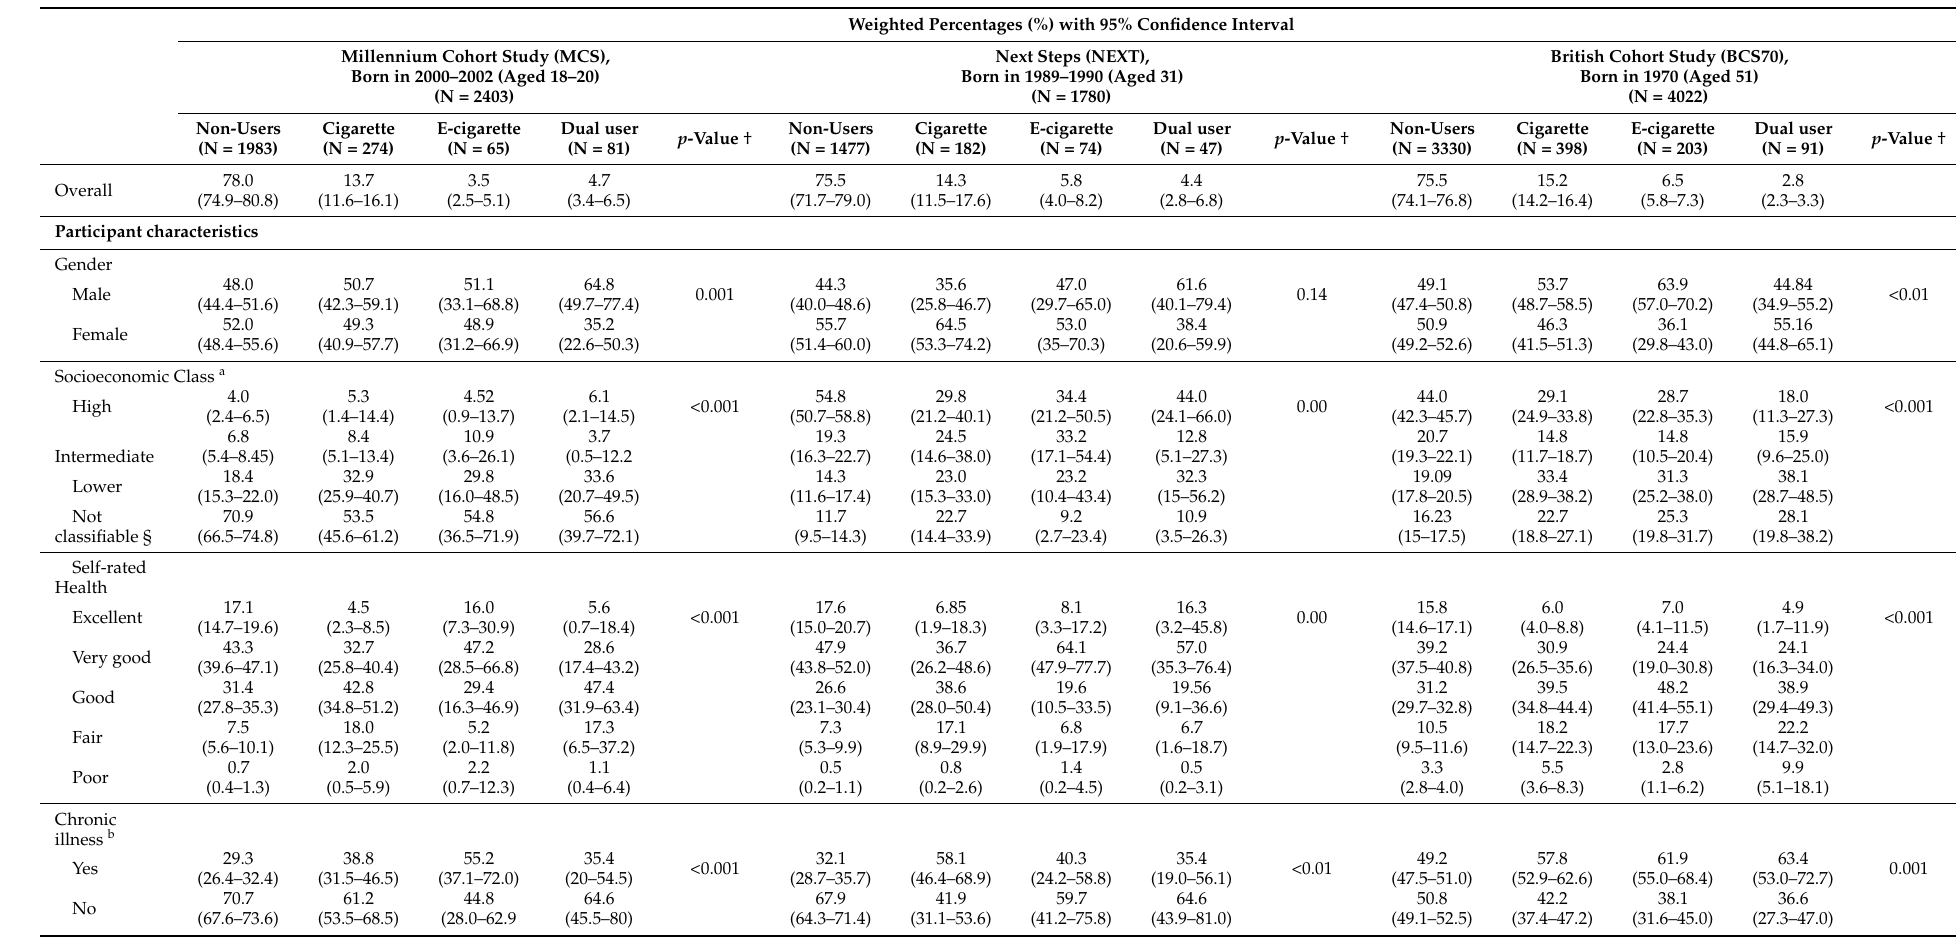
Table 1. Participant characteristics and COVID-19–related risk factors by exclusive or dual use of cigarette and e-cigarettes across four cohorts were